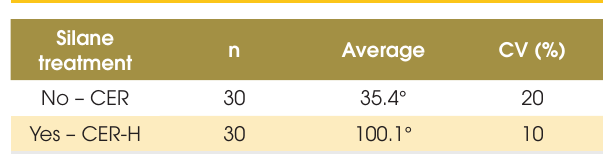
Figure 2 – Capillary action-based water absorption by untreated clay bricks and those treated superficially with silane